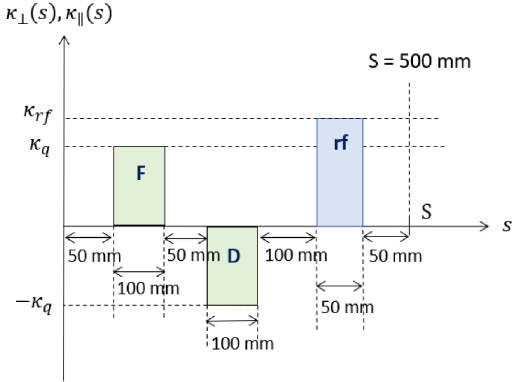
FIG. 2. Periodic focusing lattice composed of a quadrupole doublet and an rf cavity. The length of the lattice period is S ¼ 500 mm. The focusing (F) and defocusing (D) quadrupoles have the same magnitude of focusing